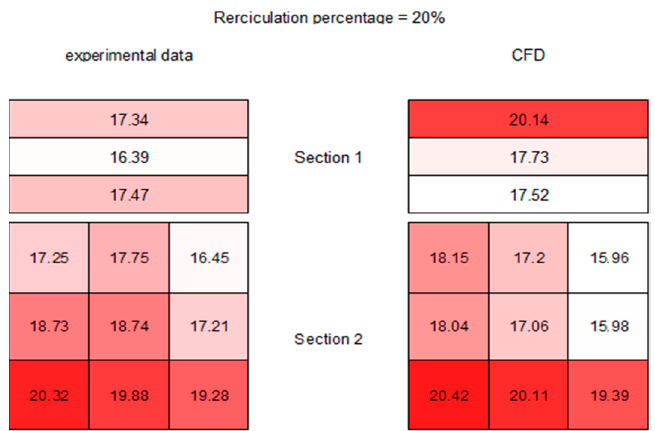
Figure 8. Comparison between experimental and CFD data for 20% WGR—O 2 mole fraction.